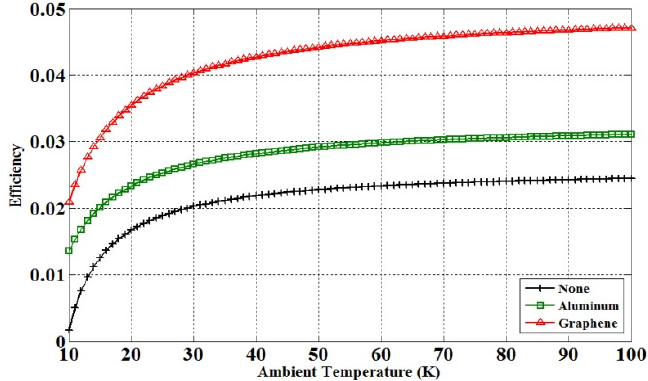
Figure 8. Simulation results of conversion efficiency of TE board with using different thermally conductive materials.